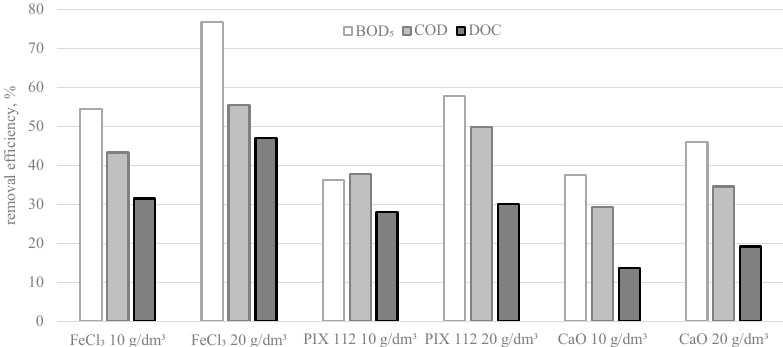
ffi ciency for FeCl · 6H 3 2 O, PIX 112 and